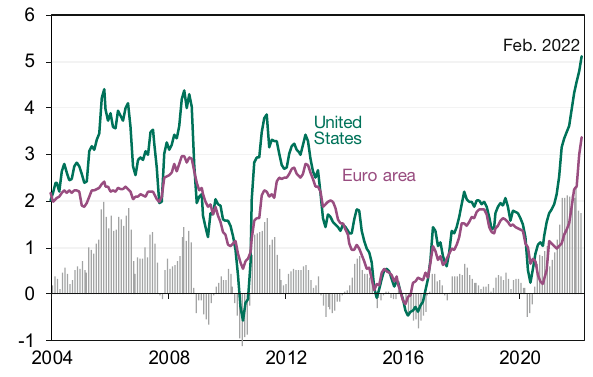
Figure 7 Percent diff erence from trend